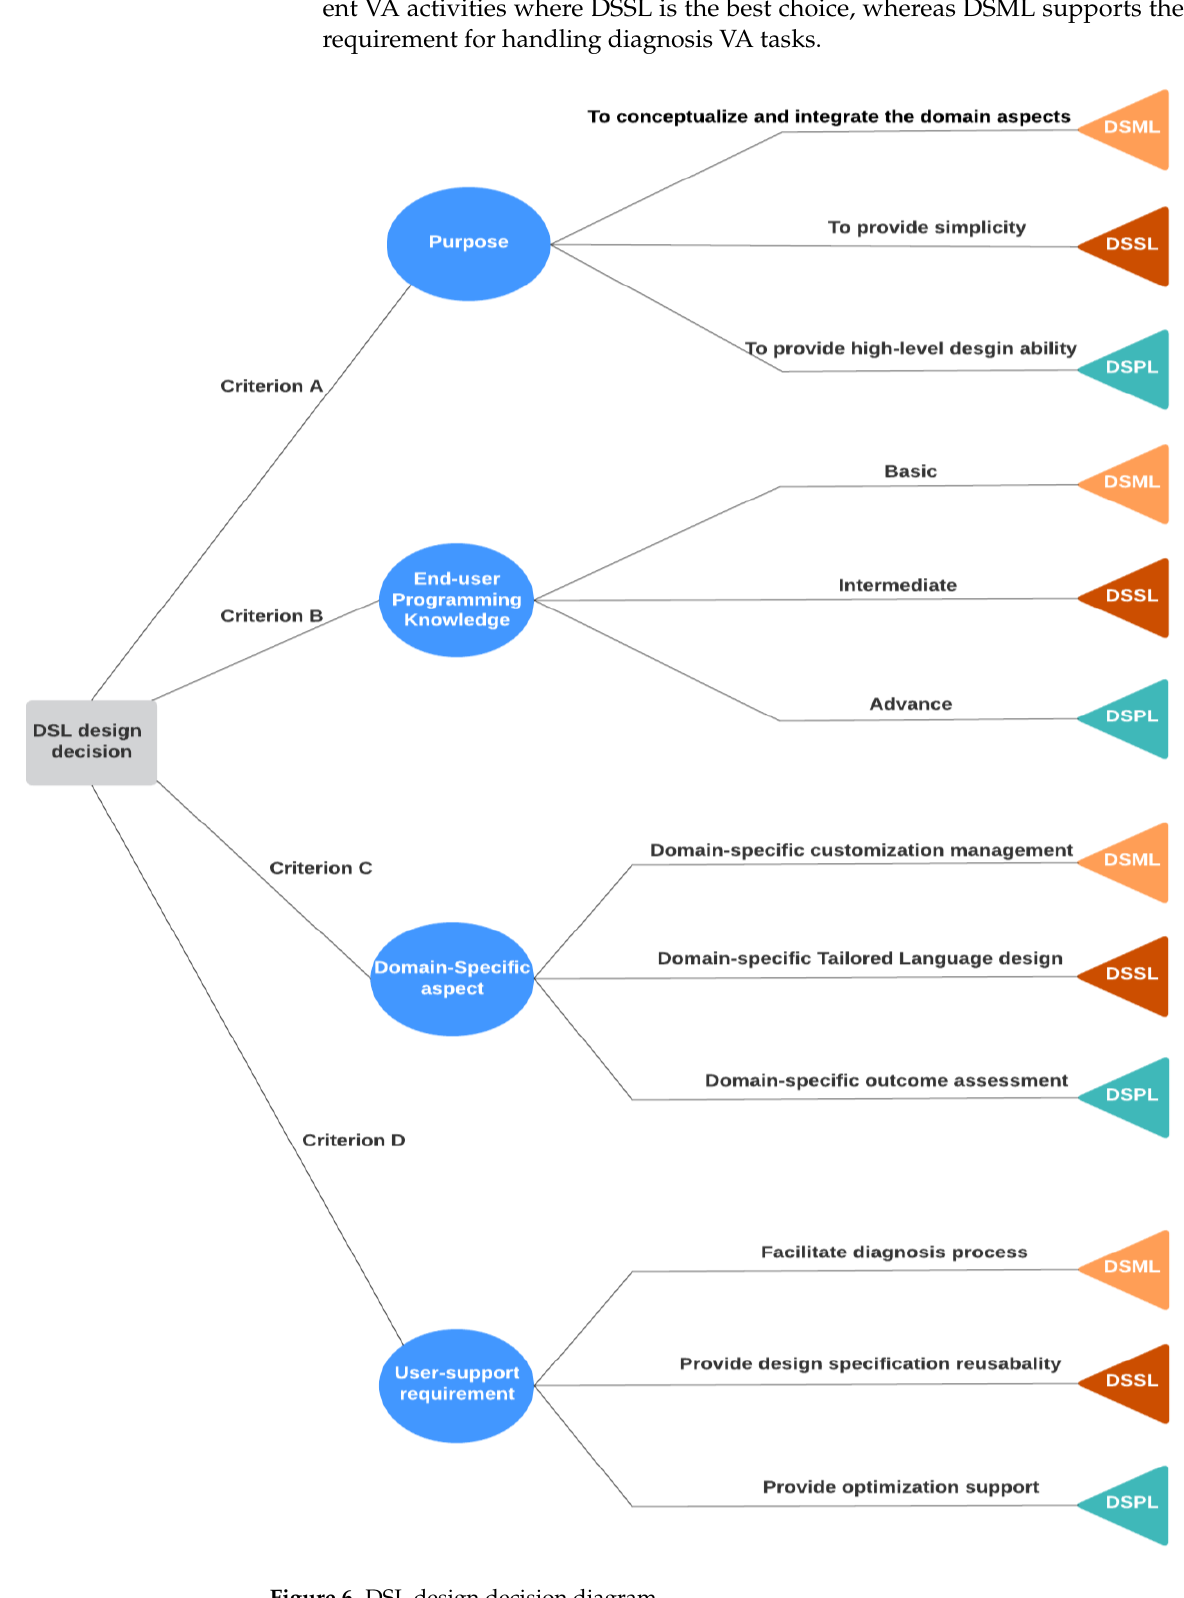
Figure 6. DSL design decision diagram.